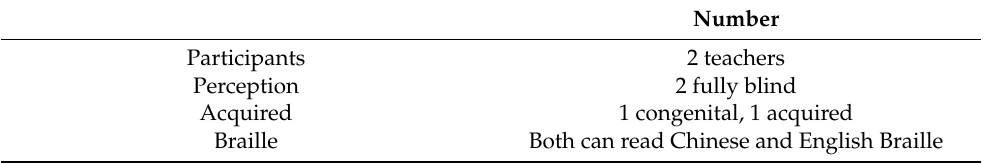
Table 2. Demographics of the